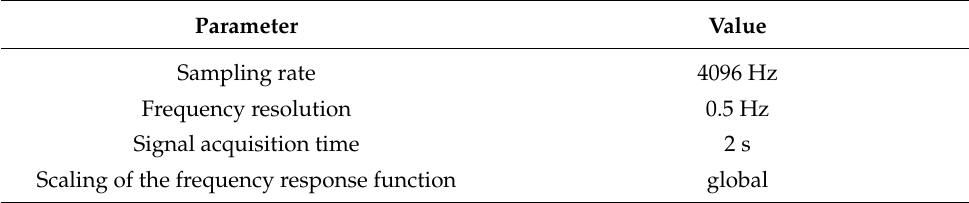
Table 3. Parameters of signal